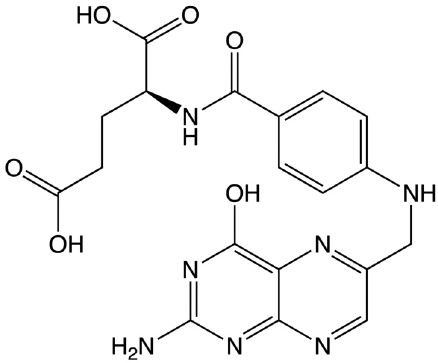
FIGURE 1 - Structure of the folic acid